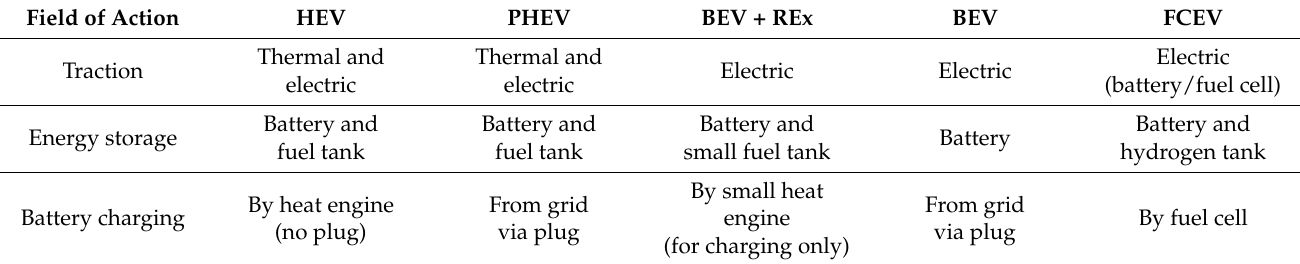
Table 1. Taxonomy of low-emission vehicles (LEVs).